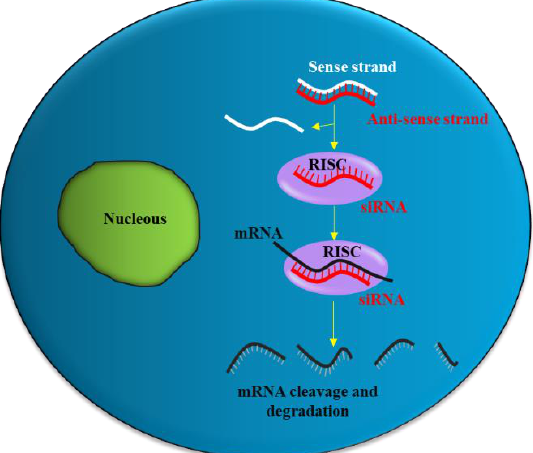
Figure 1. siRNA mechanism of action. The antisense strand (red) of the siRNA is taken up by a catalytic protein complex (RNA-induced silencing complex, RISC), and the sense strand (white) of the siRNA is discarded. The antisense strand drives RISC to a target mRNA (black), which results in specific, RISC-mediated mRNA degradation.